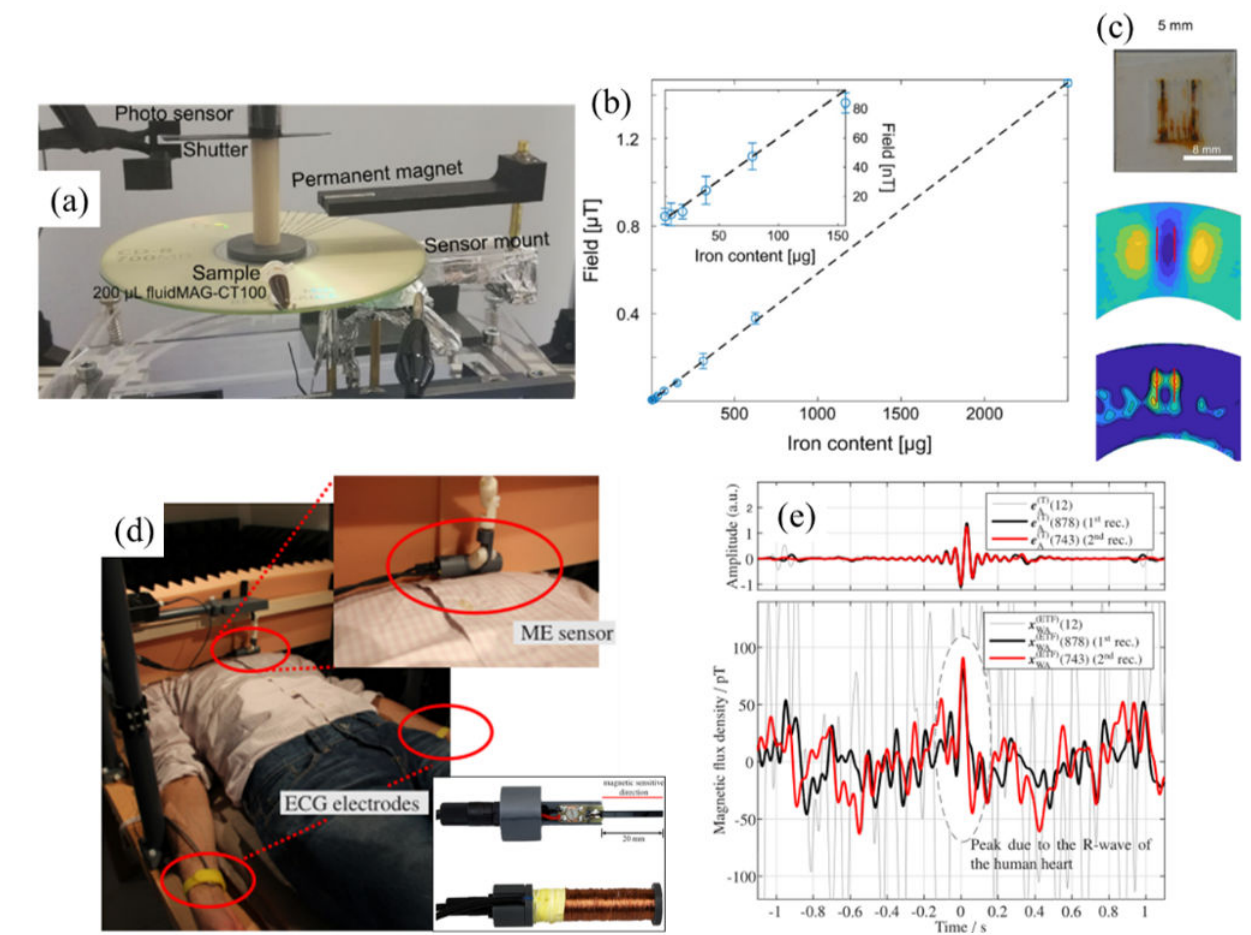
Figure 17. ( a ) Setup for measuring distributions of SPIONs. ( b ) Maximum magnetic field amplitude for different iron content measurements. ( c ) Place the sample in different grooves (top), the measured field distributions of the two sample, and the red line in the field distribution shows the location of the grooves (middle), the particle distribution reconstructed from these measurements (bottom) [92]. ( d ) Measurement setup of cardiological magnetic detection. ( e ) Averaged result of the R-wave measurement